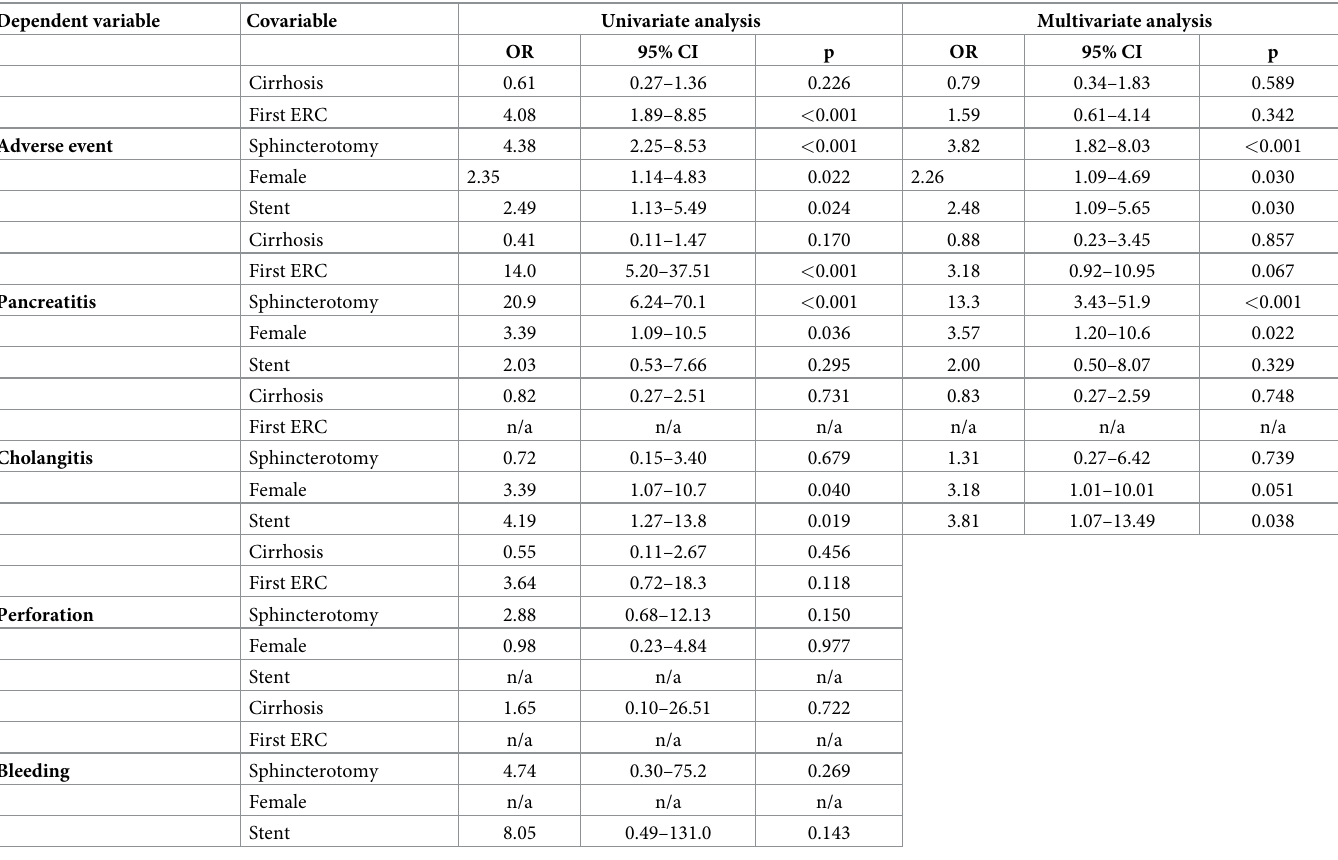
Table 4. Univariate and multivariate analysis of risk factors for post-ERC adverse